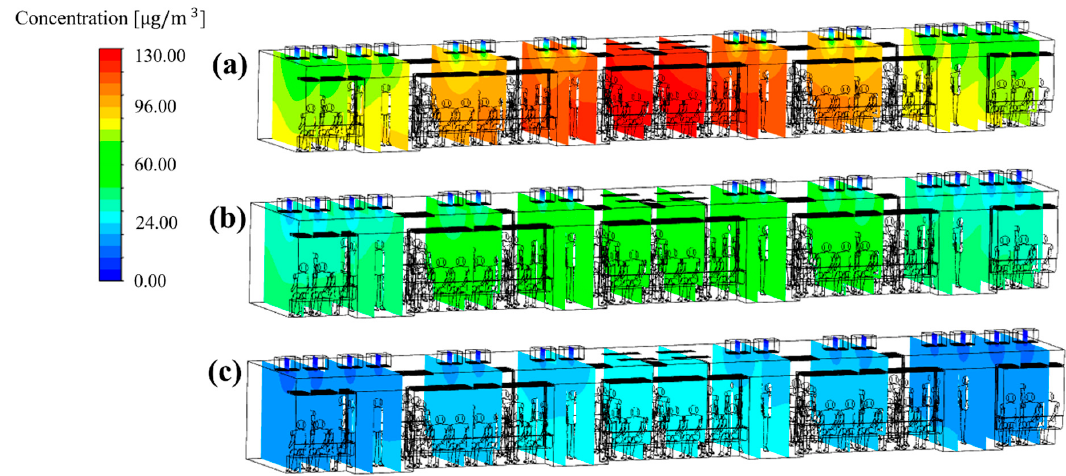
Figure 11. PM 10 concentration distribution in the subway cabin according to the filter efficiency for the flow rate ratio of 0:0:100 (total ventilation flow rate: 500 CMH): ( a ) 70% (case 5); ( b ) 80% (case 25); and ( c ) 85% (case 26).